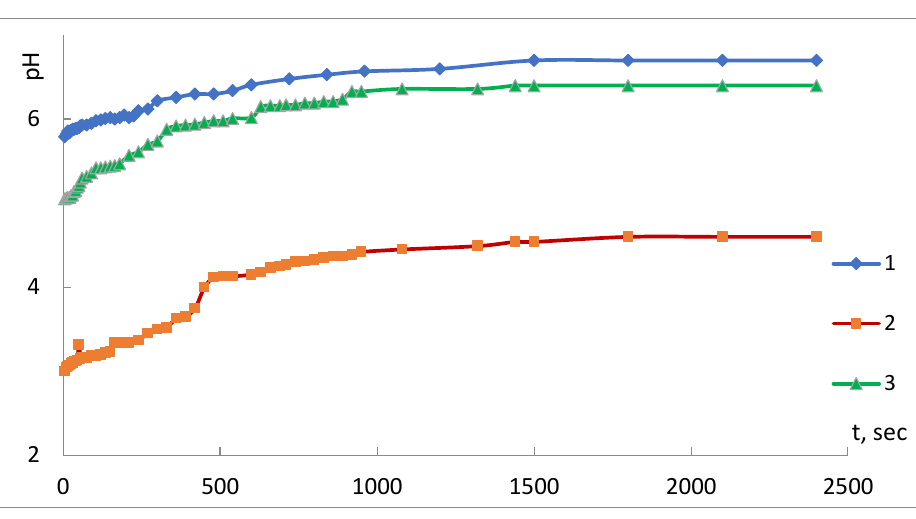
Figure 4. Spectra of adsorption centers’ distribution on the PP fiber surface: ( 1 )—raw; ( 2 )—modified by Fe 0 using the SHF method; ( 3 )—modified by Fe 0 using the II method. Analysis of the kinetic curves of pH variation of the composite in water indicates that the time taken to achieve the adsorption-electrochemical equilibrium, and establishment of a constant value of the pH parameter of the isoionic state (pH iis ), is from 1500 to 2400 s. The shape of the kinetic curves allows concluding about an increase in acidity of the composites’ surface state in comparison with the raw PP fiber. It is especially noticeable that the composite obtained using the SHF method is conditioned, in the authors’ opinion, by the large quantity of the metal in this sample (Table 2).